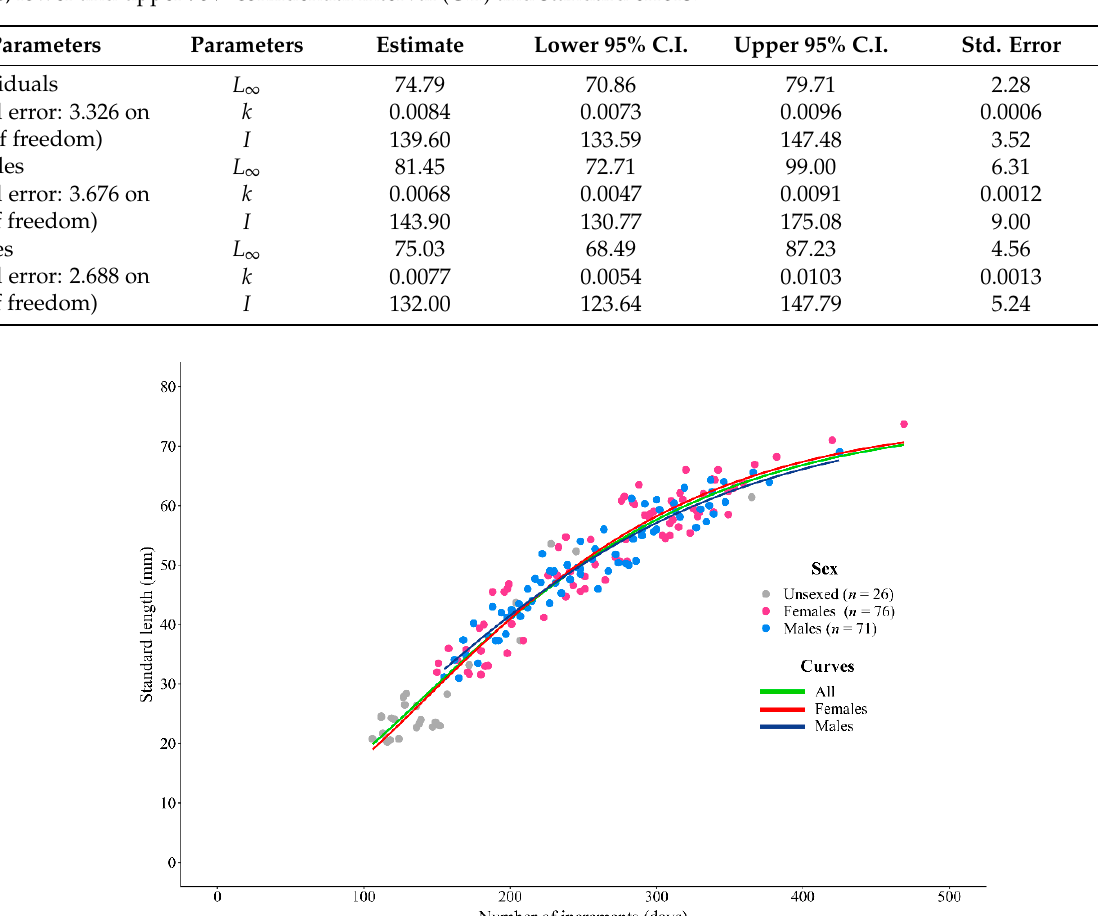
Table 3. Results of the parameters of the best fitting models of all individual, females and males. Information includes L ∞ , k and I estimates, lower and upper 95% confidential interval (C.I.) and standard errors.